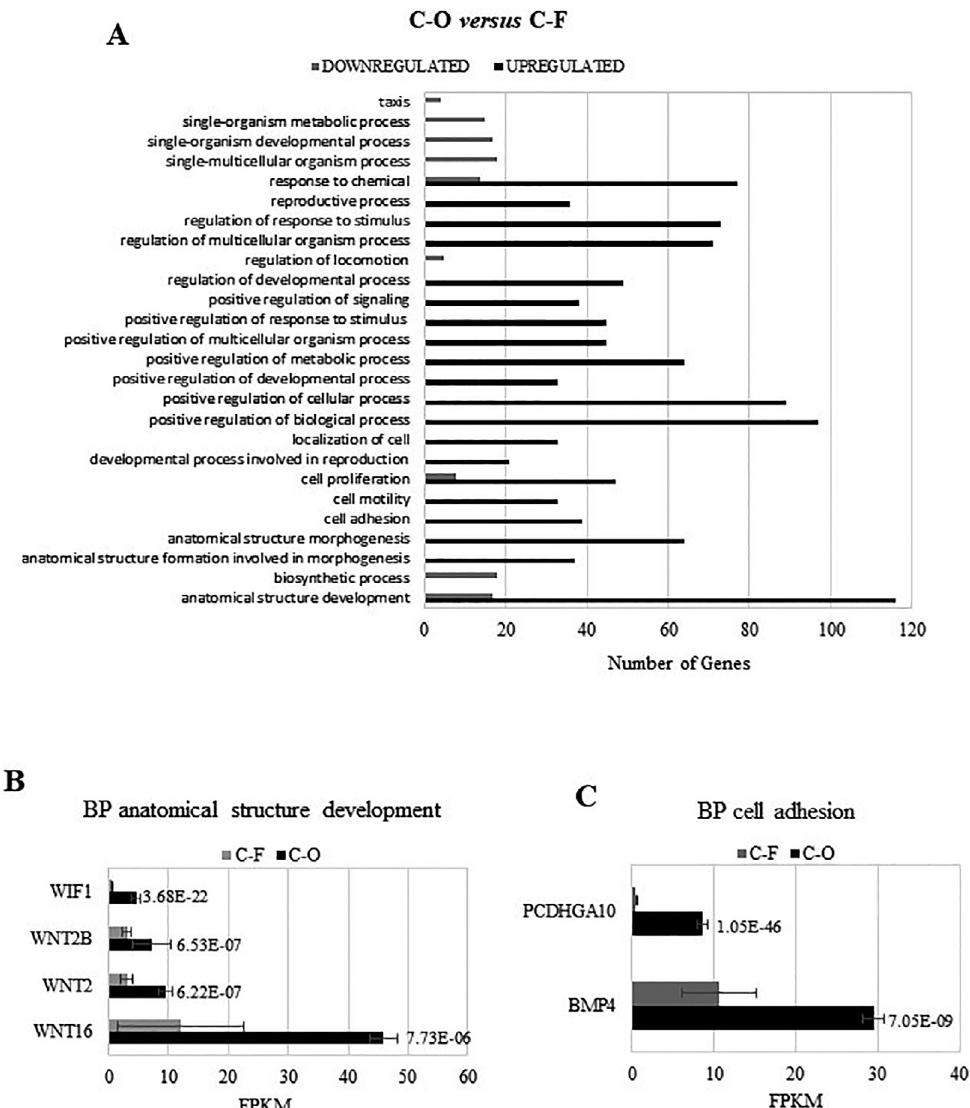
Figure 4- Gene Ontology (GO) of Biological Processes (BP) enrichment analysis of the list of differentially expressed genes between C-O and C-F clones. GO analysis was generated by the DAVID software based on biological processes (GO_TERM_BP_2 database). (A) Number of genes upregulated and downregulated in C-O clones according to GO of Biological Processes. (B) Bar plot of FPKM of upregulated genes in C-O clones for anatomical structure development biological processes. (C) Bar plot of FPKM of upregulated genes in C-O clones for cell adhesion biological processes. Differential expression determined by using of negative binomial generalized linear model (DESeq) in (B) and (C) bar